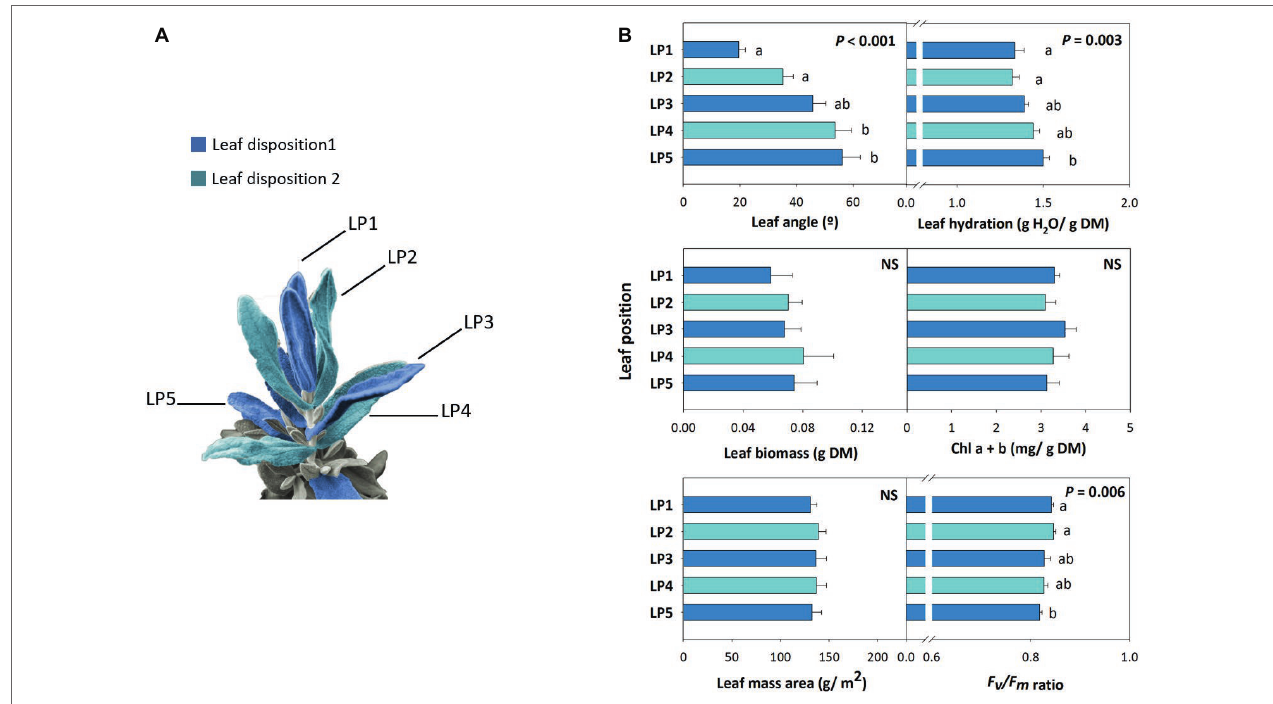
FIGURE 3 | Positional effects in leaf orientation in the Mediterranean shrub, C. albidus . (A) Schematic representation of the disposition on the shoot (Leaf disposition 1 and 2 shown in dark blue and light blue, respectively) of the five leaf positions (LP1…LP5). (B) A comparison between leaf positions on leaf angle, biomass, mass per area ratio, hydration, chlorophyll contents, and the F v / F m ratio in plants growing at the experimental garden of the University of Barcelona in January at midday is shown. Data represent the mean ± SE of n = 6 individuals. Significant differences in “Leaf position” were tested by conditional Fisher tests ( p ≤ 0.05), and different letters indicate significant differences in Tukey’s HSD multiple comparison test ( p ≤ 0.05). NS, not significant; DM, dry